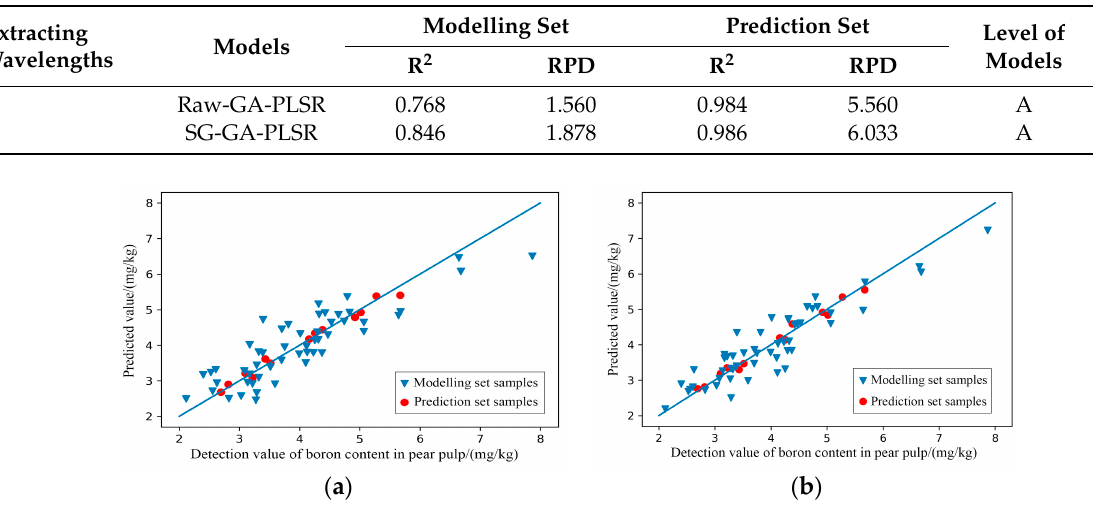
Figure 9. Scatter plots of models’ prediction results of the content of boron in pear pulp samples. ( a ) Raw-GA-PLSR; ( b ) SG-GA-PLSR.